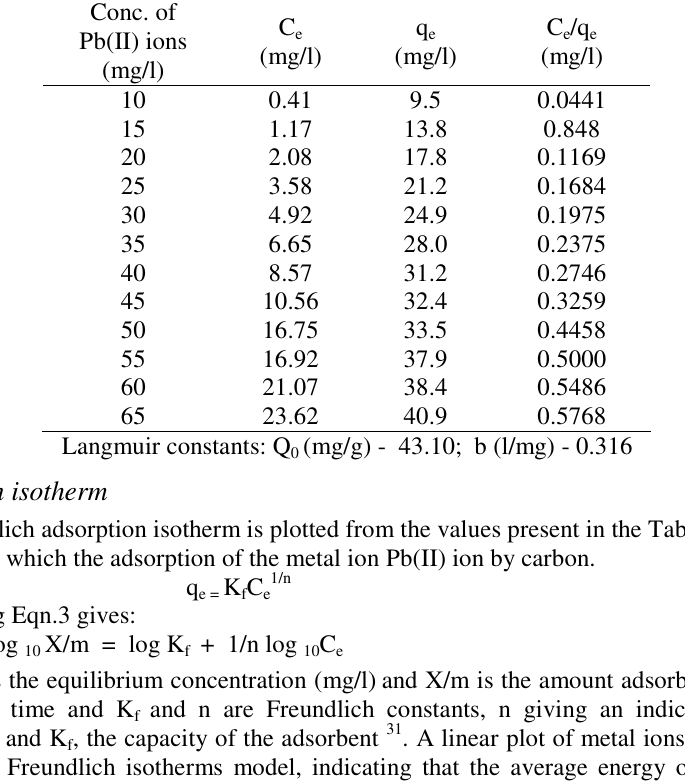
Table 3 Data for Langmuir plot for adsorption of Pb(II)